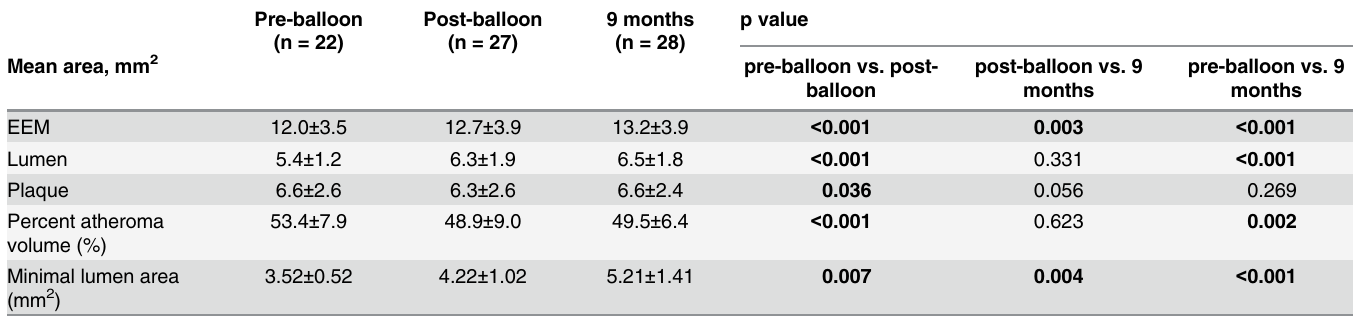
Table 4. Serial changes of grey-scale IVUS parameters in pre- and post-balloon and at 9 months follow-up.